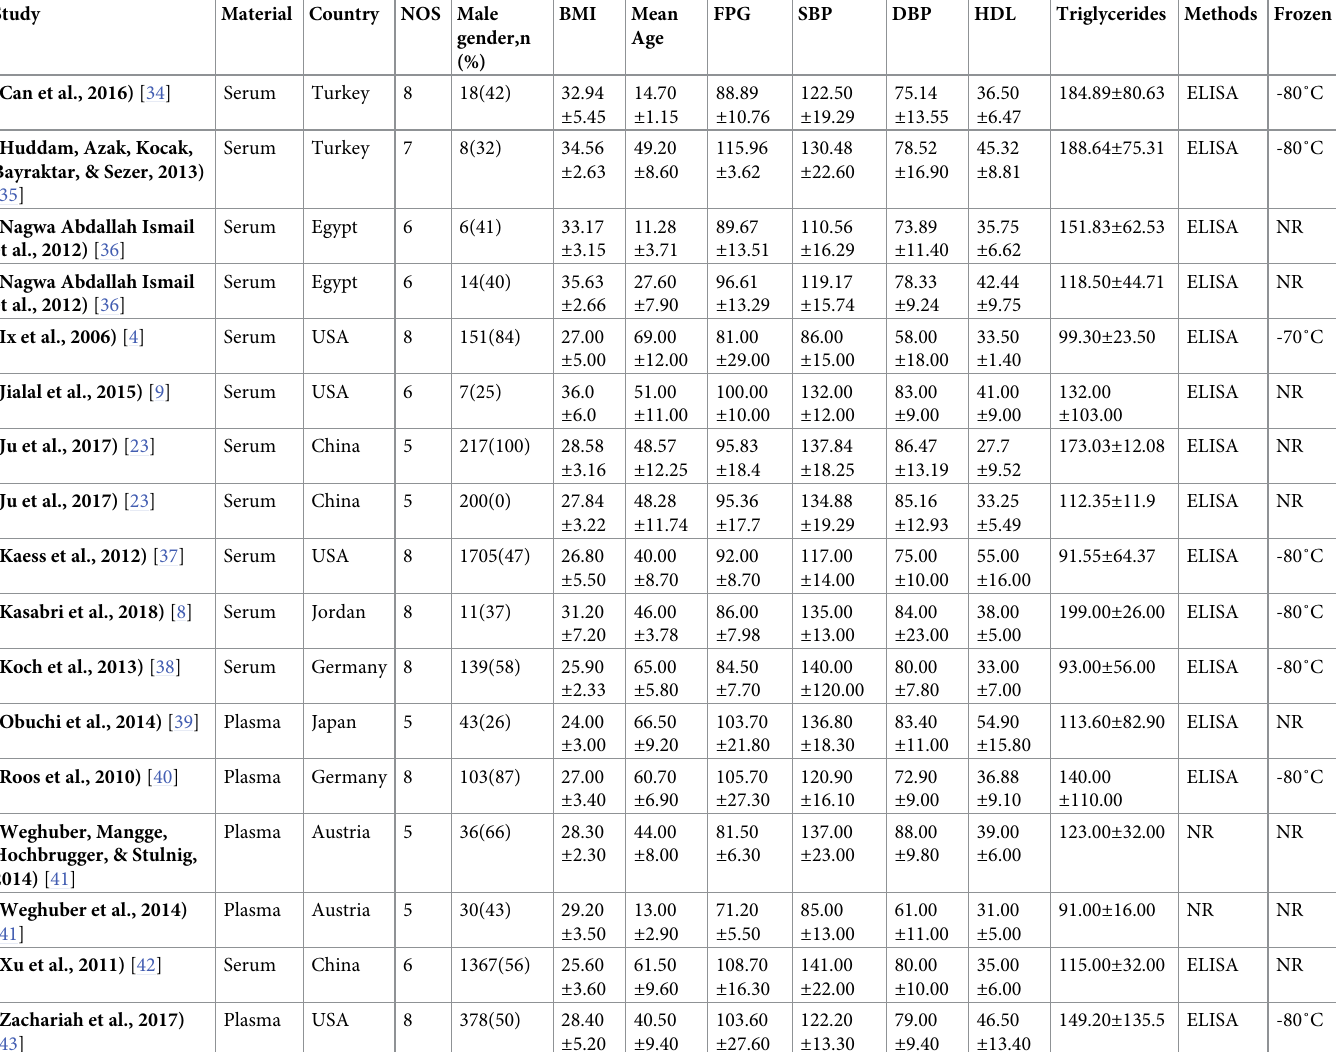
Table 1. Characteristics of the studies included for the meta-analysis of fetuin-A and MetS.